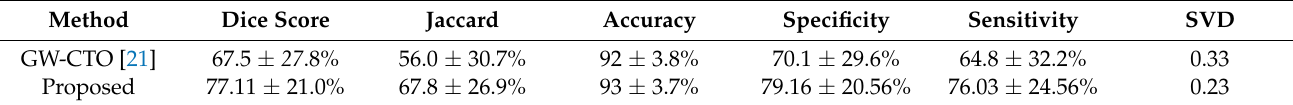
Table 2. Segmentation Results on 3DIRCADb1